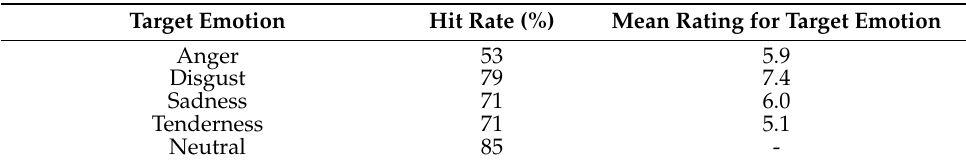
Table 4. Results for target